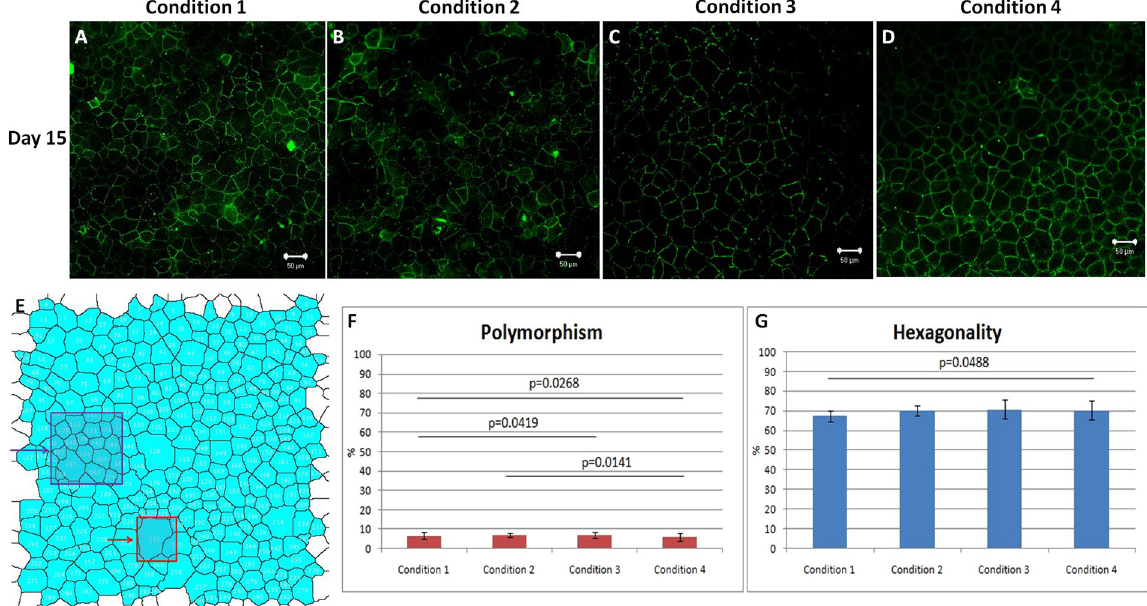
Figure 4. ZO-1 staining for intracellular tight junctions and to determine the polymorphism and hexagonality of the cells in different conditions. ( A – D ) The cultured HCEnCs showed expression of ZO-1 in all conditions. ( E ) The image was locked in imageJ and was processed to overlay masks for determination of hexagonal cells and number of cells that showed high polymorphism (polymegathism and pleomorphism). Purple block represent number of hexagonal cells and red block indicate highly polymorphic cell in the determined area. ( F ) Polymorphism was significantly lower in C4 and C3 compared to C1 and C2 with C1–C4 (p = 0.0268), C1–C3 (0.0419) and C2–C4 (p = 0.0141) showing less polymorphic cells in C3 and C4 compared to other conditions whereas ( G ) Hexagonality was significantly higher between C1–C4 (p = 0.0488) at day 15. Scale bar = 50 µ